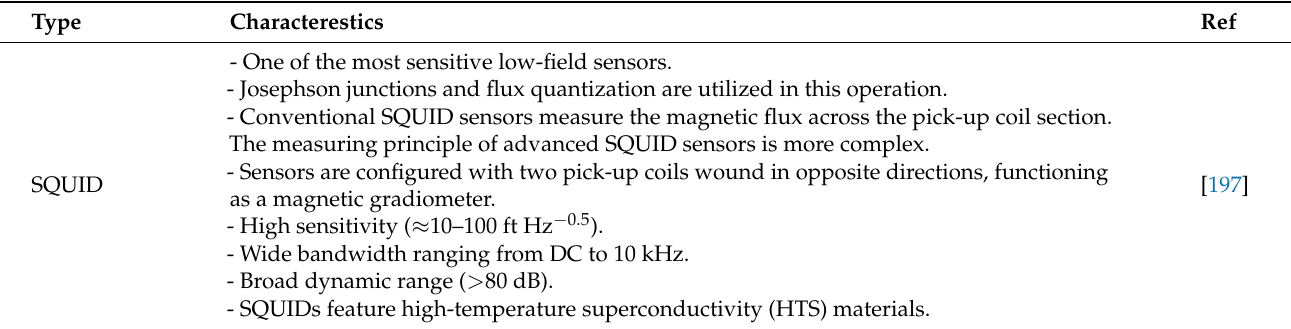
Table 10. Overview of current advanced magnetic